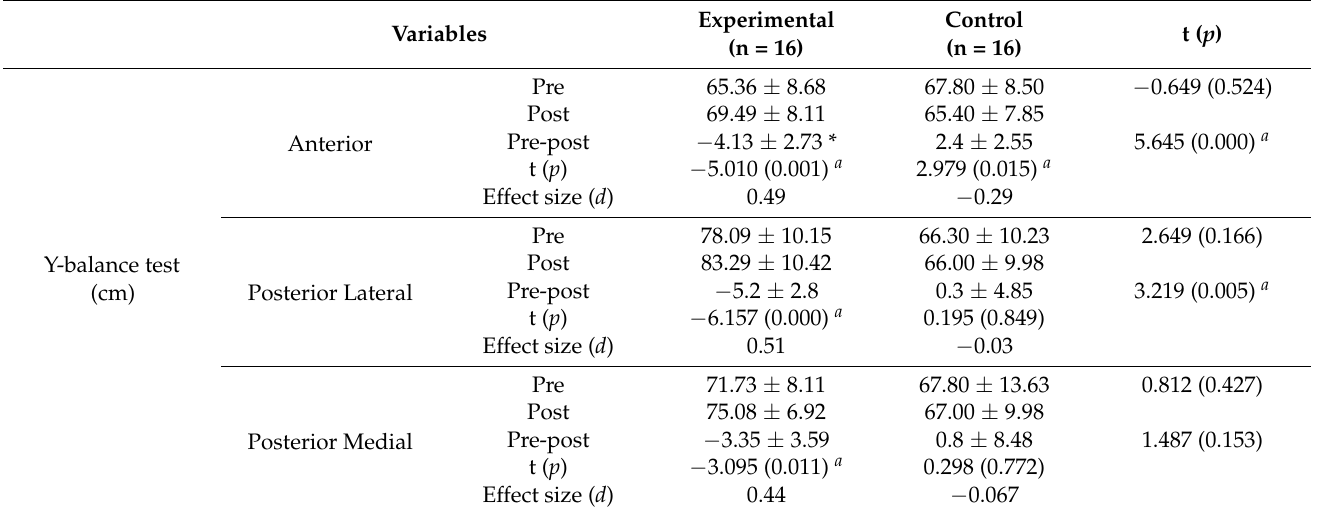
Table 7. Comparison of Y-balance test results within and between